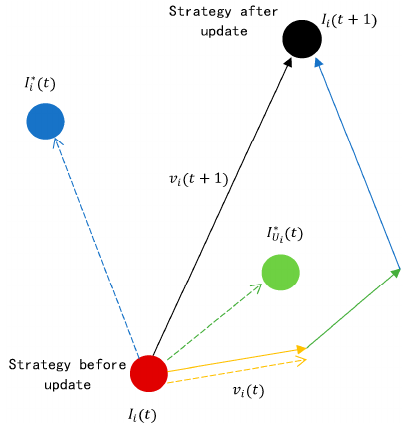
Figure 1. The conceptual graph of the model under study.